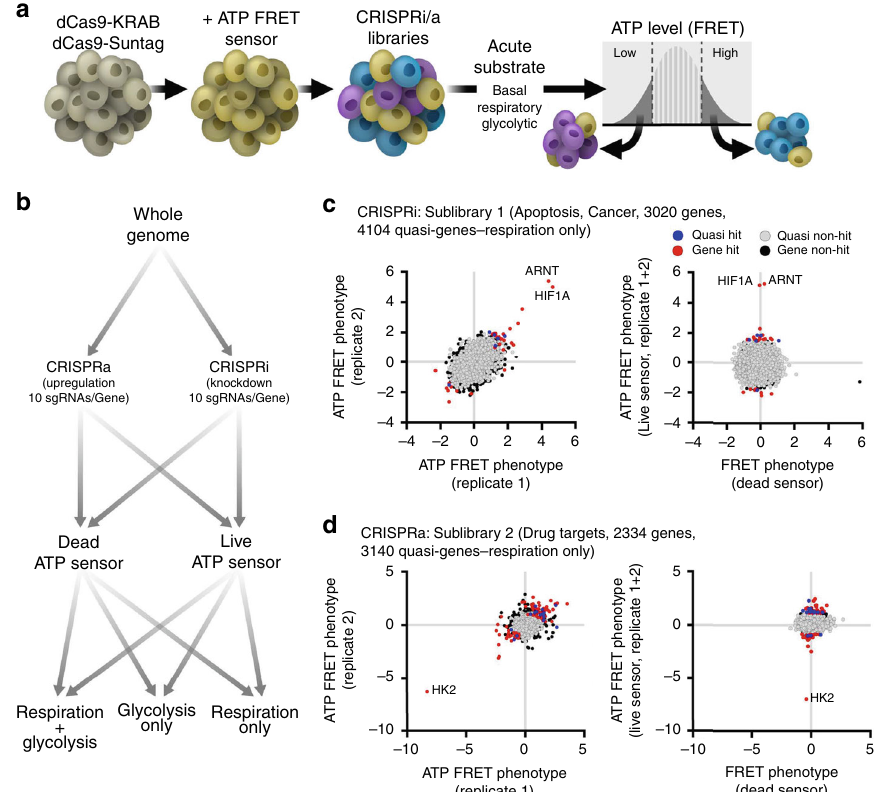
Fig. 1 Whole-genome screens to identify genetic modi fi ers of ATP. a , b Schema shows single-cell detection and sorting based on ATP. K562 cells stably expressing either dCas9-KRAB (CRISPRi) or dCas9-Suntag (CRISPRa), and an ATP FRET sensor (Clover and mApple separated by an ATP-binding domain or dead sensor) were transduced with either CRISPRi (downregulation) or CRISPRa (upregulation) sgRNA sublibraries with ten sgRNAs/gene. Cells were then exposed to substrate and drug conditions forcing ATP synthesis from glycolysis only (5 μ M oligo and glucose), oxidative phosphorylation only (pyruvate and 10 mM 2DG), or allowing either (basal) for 30 min prior to sorting. Cells in the lowest and highest ATP quartiles were isolated by fl ow cytometry, and the relative enrichment of each sgRNA was quanti fi ed by deep sequencing. Adapted from ref. 4 . c , d Individual gene phenotypes in sample CRISPRi ( c ) and CRISPRa ( d ) sublibraries in respiratory conditions. FRET phenotype is the average of the three sgRNAs with the largest phenotypes. Graphs on left show ATP FRET phenotype of replicate 1 ( X -axis) versus 2 ( Y- axis). High ATP gene hits (red) show increased phenotype on both repetitions, while quasi-gene hits (blue) indicate false positives. Graphs on right show FRET phenotype for the live ATP FRET sensor ( Y -axis) versus dead FRET sensor ( X -axis). ATP hits do not have signi fi cantly altered FRET phenotypes with the dead sensor, indicating the speci fi city of the live sensor phenotype for ATP. sgRNA with large dead sensor phenotypes were excluded from analysis. Source data are provided as a Source data fi